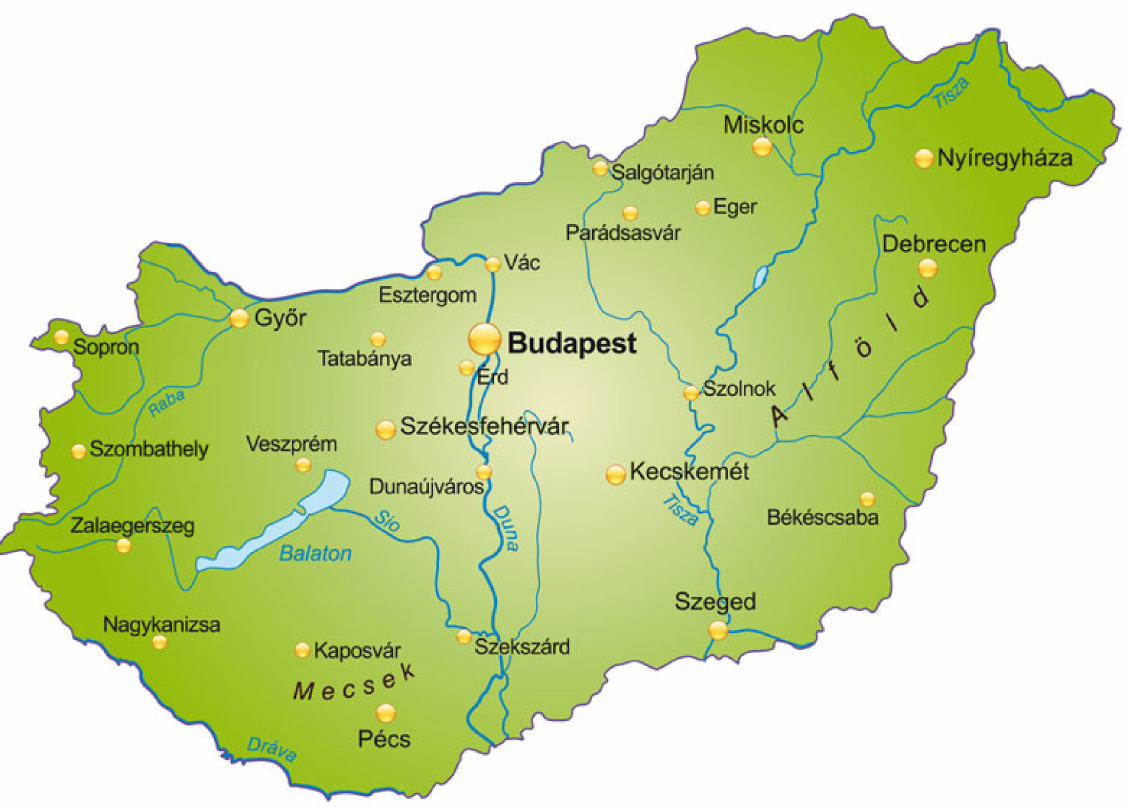
Figure 9. Map of Hungary with Lake Balaton and the Si ó canal linking the lake to the river Danube.